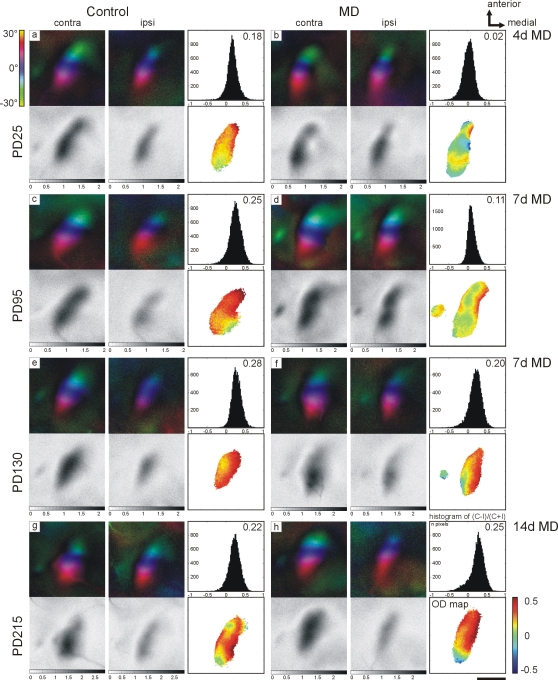
Ocular dominance plasticity in mouse visual cortex is age-dependent.Representative experiments of animals in all four age groups studied (PD25, PD95, PD130 and PD215) are displayed. Optical imaging maps of responses to the ipsi- and contralateral eye in the binocular region of mouse visual cortex in both control animals (left column: a, c, e, g) and monocularly deprived animals (right column: b, d, f, h) are shown. Both colour-coded polar maps of retinotopy (top) and grey-scale coded response magnitude maps (below) are illustrated. For each experiment, the histogram of ocular dominance scores, the average ocular dominance index (ODI) and the corresponding 2-D ocular dominance maps (ODI values colour-coded according to the scheme shown in the lower right corner of the figure: blue represents negative, red positive values) is included. Note that in control animals of all ages, activity patches evoked by the stimulation of the contralateral eye were consistently darker than those after stimulation of the ipsilateral eye (a, c, e, g) and that 2-D ocular dominance maps are red and yellow indicating contralateral dominance. In contrast, monocular deprivation for 4 days in PD25 animals (b) or for 7 days in PD95 animals (d) induced a significant ocular dominance shift so that the response magnitude maps of both ipsi- (open) and contralateral (deprived) eye are now equally dark, the histograms of ocular dominance scores shift to the left (compare a to b and c to d) and colder colours prevail in the 2-D ocular dominance maps. In the two older animal groups, PD130 and PD215 mice, monocular deprivation for 7 days (f) or 14 days (h) fail to induce ocular dominance shifts and both histograms of ocular dominance scores and 2-D ocular dominance maps are similar to control animals (compare e to f and g to h). The scale bar is 1 mm and applies to all panels showing maps. Abbreviations: MD = monocular deprivation, OD = ocular dominance, contra = contralateral eye, ipsi = ipsilateral eye.